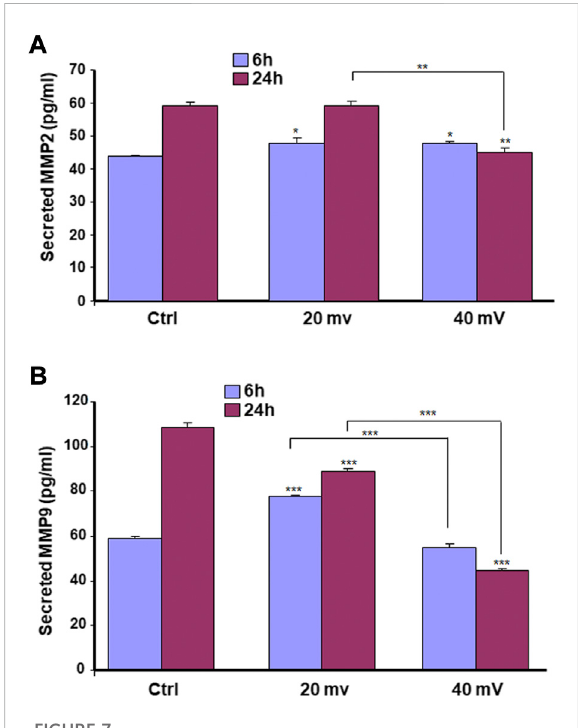
FIGURE 6 ES modulates the secretion of EGF (A) and FGF-7 (B) by diabetic skin cells. DHSE were exposed to 20 or 40 mV/mm of ES for6and24 h.Immediatelyaftereachexposureperiod,theculture medium was used to measure le levels of EGF and FGF-7 as reported in the M&M. Results are expressed as means ± SD from triplicate assays of three different experiments. (ns), non- signi fi cant. * p ˂ 0.05, ** p ˂ 0.01, *** p ˂ 0.001. Free asterisks refer to the statistical difference when comparing the ES-exposed and nonexposed(Ctrl)tissues.Barswithasterisksshowthecomparison of the different intensities of ES.